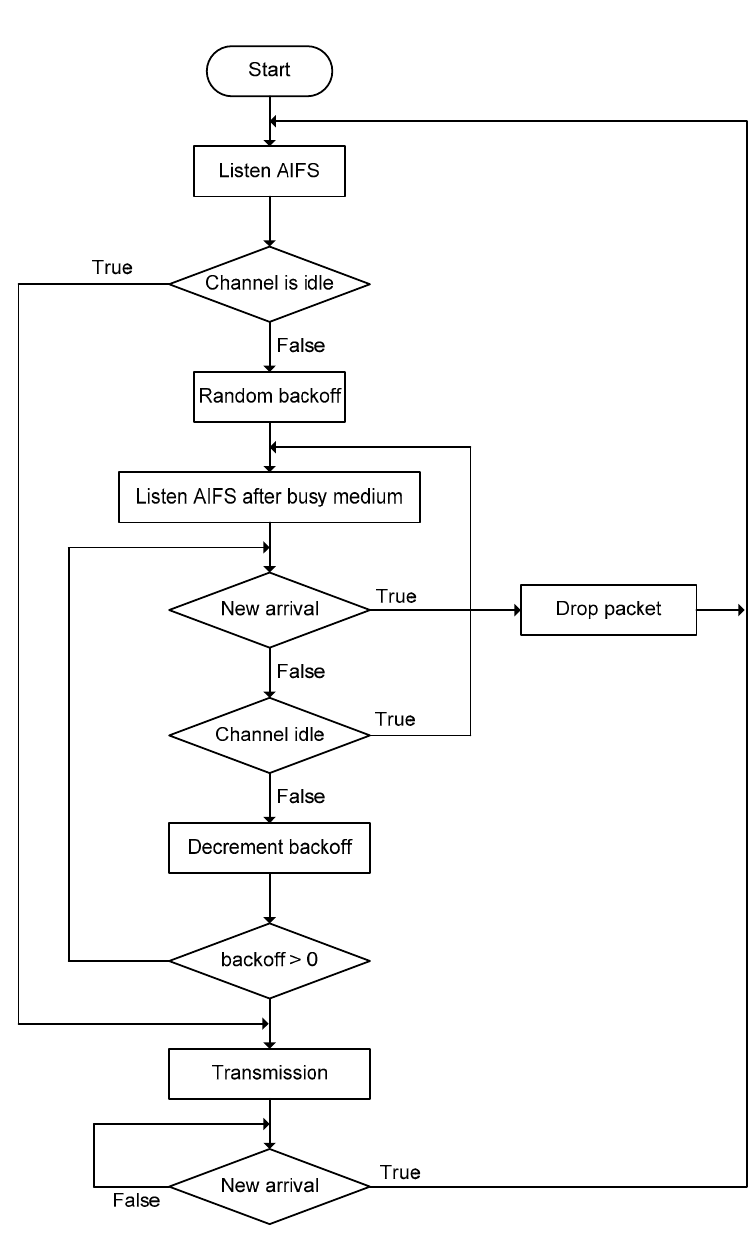
Figure 3. AIFS-based procedure .